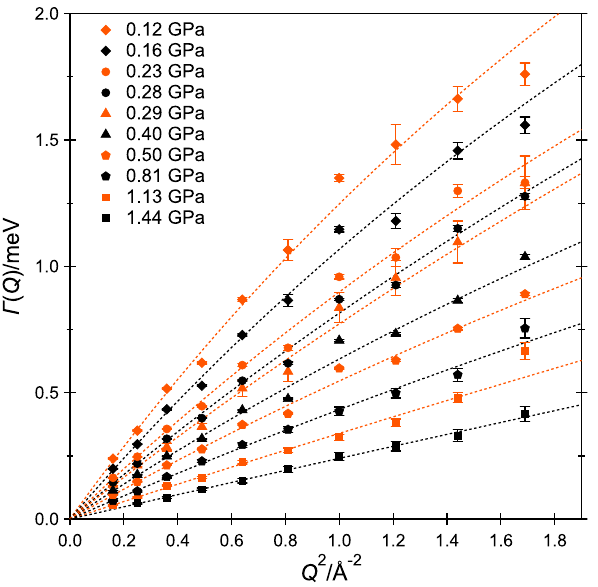
Fig. 2 Wavevector transfer Q dependence of the QENS signal. Half-width at half maximum Γ ( Q ) of the Lorentzian fi ts of the quasi-elastic signal as a function of Q 2 . Error bars correspond to one standard deviation, as obtained from fi ts such as those of Fig. 1. The best fi ts to the data using Eq. (1) are shown as dashed lines.